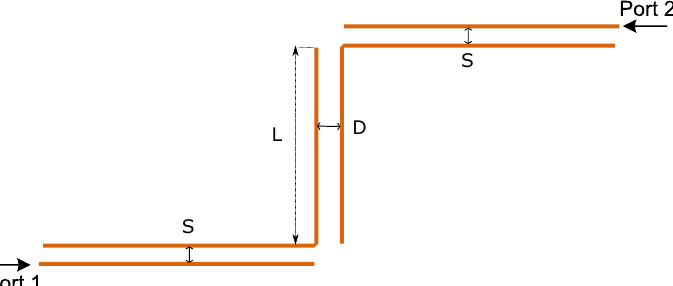
Figure 8. Top-view of the zigzag bandpass